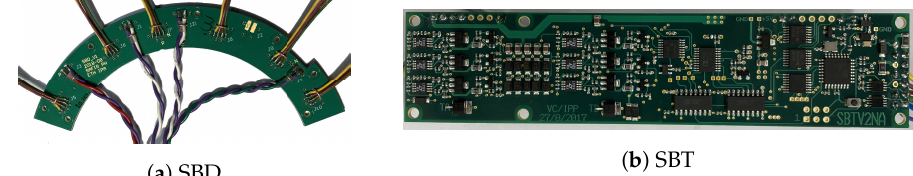
Figure 11. ( a ) Starting from the bias power supplies we use two SBDs to supply the required input voltages to all SBTs. The SBDs connects to the bias power supplies via four twisted-pair cables (at the bottom of the image) and serves six SBTs. ( b ) The SBT regulates up to six bias voltages between − 50V and −